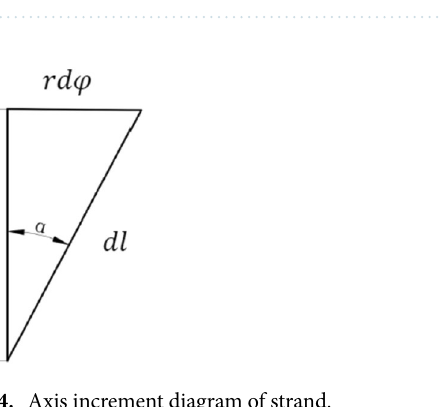
Figure 3. Diagram of conductor bending.